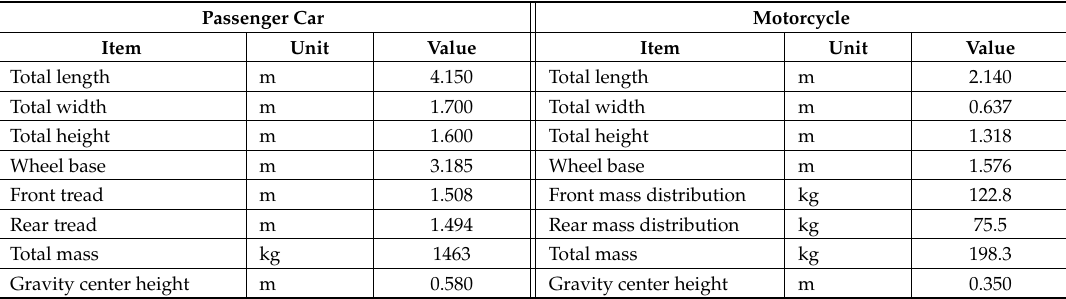
Table 3. Specifications of passenger car and motorcycle.